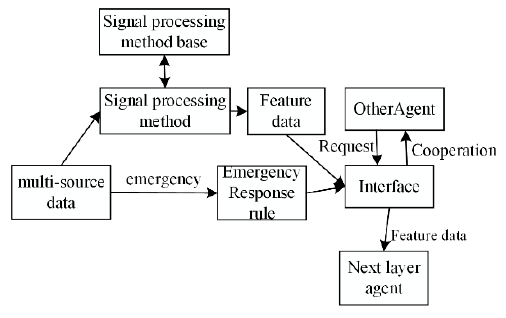
Figure 4. The internal structure and principle of the